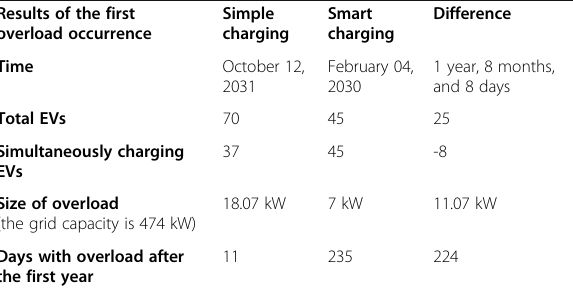
Table 1 (Abstract P11). Generated results from the current agent- based